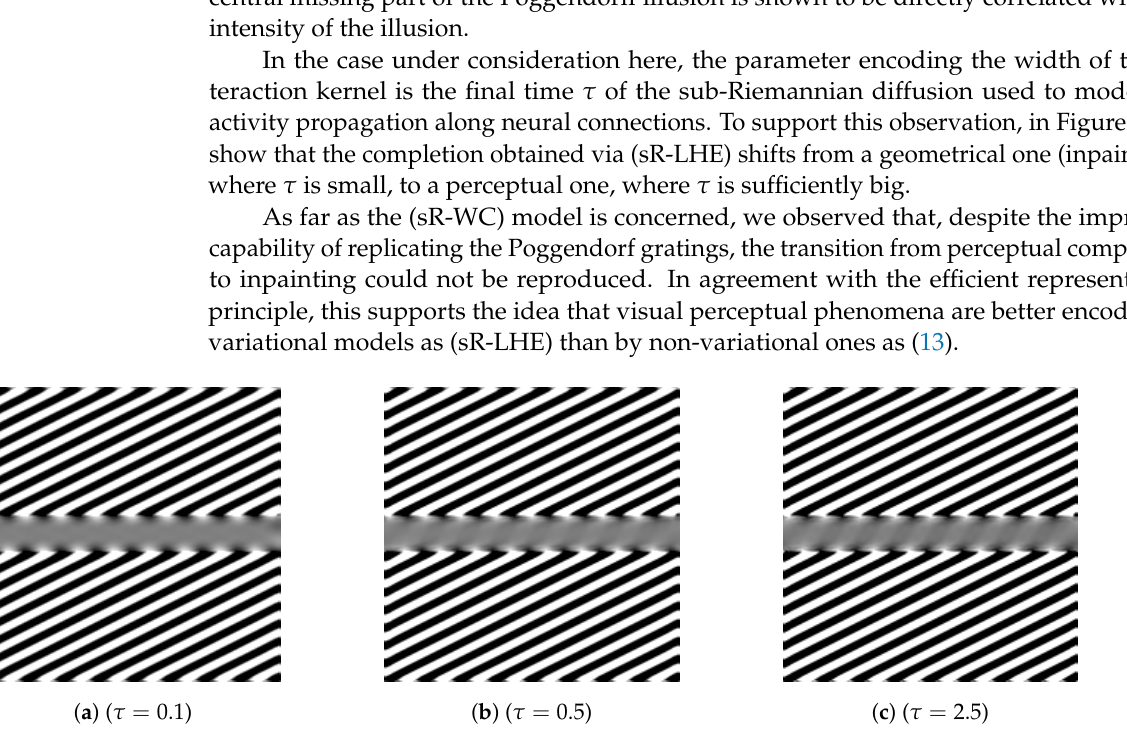
Figure 6. Sensitivity to the parameter τ for (sR-LHE) model for the visual perception of Figure 3b. The completion inside the central grey bar changes from geometrical (inpainting type) to illusory (perception type). Parameters: τ varies from 0.1 to 5, α = 6, λ = 2, σ µ = 1, ∆ t = 0.15, ∆ τ =